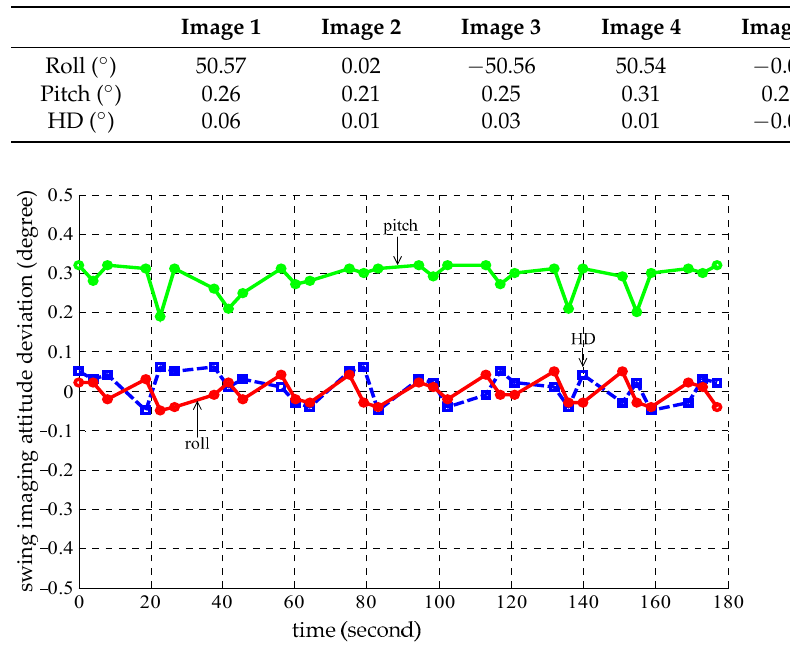
Figure 17. Image attitude deviation in sweep imaging mode over time.